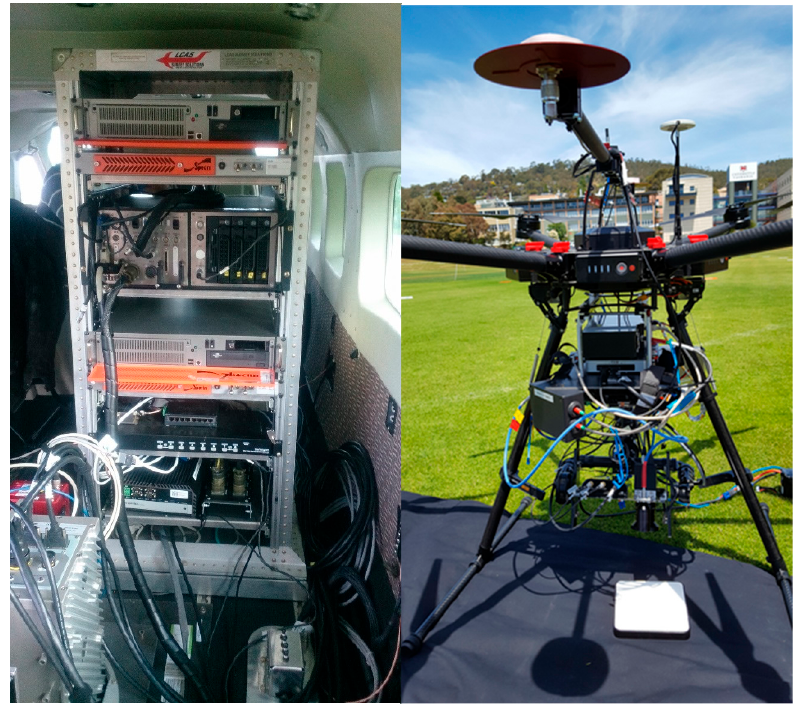
Figure 5. Two di ff erent F sensors installed on di ff erent platforms: HyPlant installed in an aircraft ( left ) Figure 5. Two different F sensors installed on different platforms: HyPlant installed in an aircraft (left) and AirSIF system [95] with QE pro of the Terraluma group installed on a multirotor UAV ( right and AirSIF system with QE pro of the Terraluma group installed on a multirotor UAV (right).